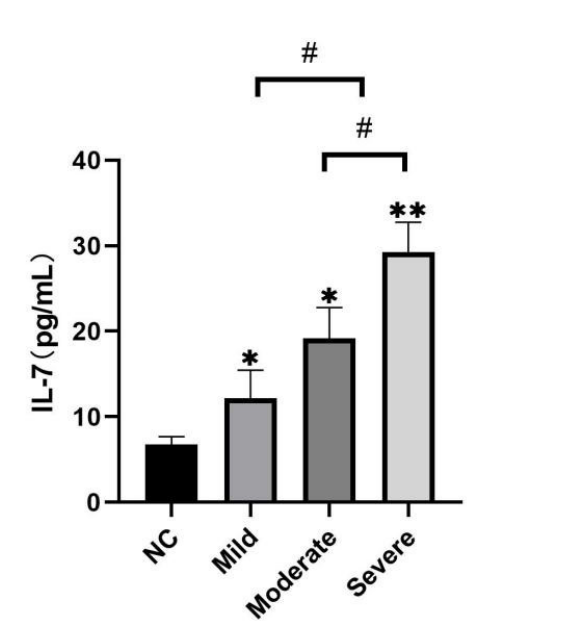
Fig. 2 - Upregulation of the expression of IL-7 in peripheral blood serum of patients with CHD. The expression level of IL-7 in peripheral blood serum of the study subjects in each group was detected by ELISA. *Compared with the control group, *P<0.05, **P<0.01; #